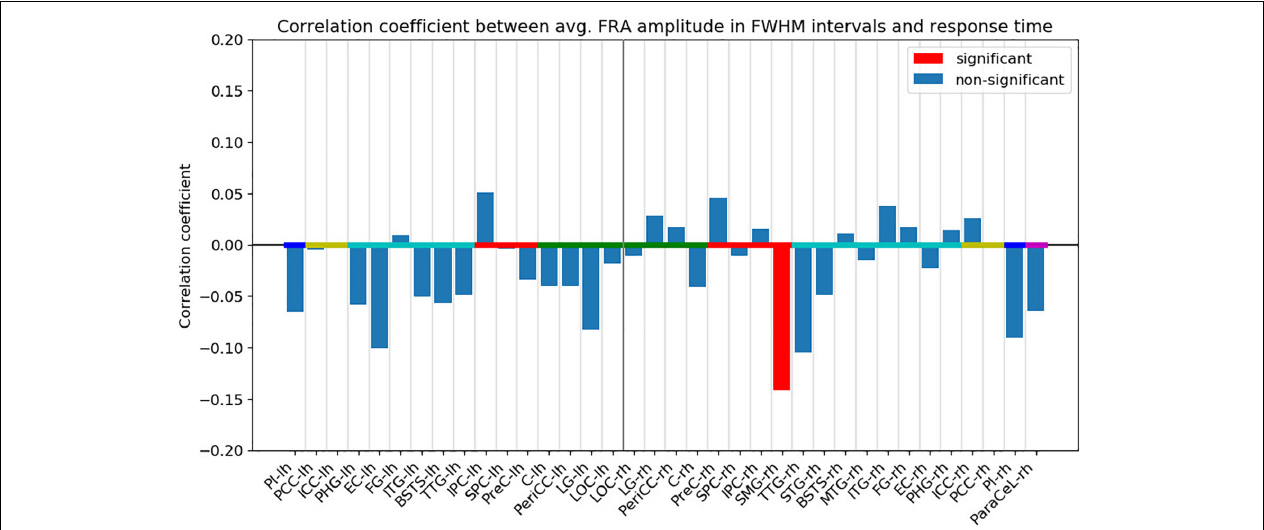
FIGURE 6 | Pearson’s correlation coefficient between the absolute ROI time course FRA amplitude averaged across the FWHM time intervals and the response time. Red bars indicate that the correlation coefficient was significant ( p < 0.05) after FDR-correction. The ROIs are ordered by hemisphere and anatomical higher-level regions (frontal lobe: magenta, insula: blue, cingulate cortex: yellow, temporal lobe: turquoise, parietal lobe: red, occipital lobe: green). “lh” and “rh” stand for left and right hemisphere,